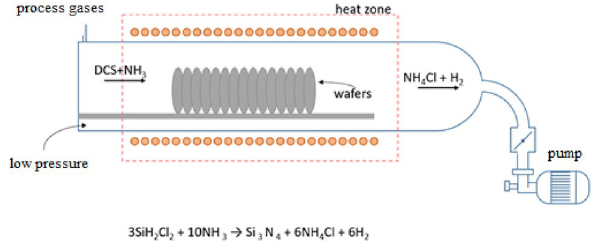
Figure 1. Scheme of LPCVD furnace used for the SiN deposition process.